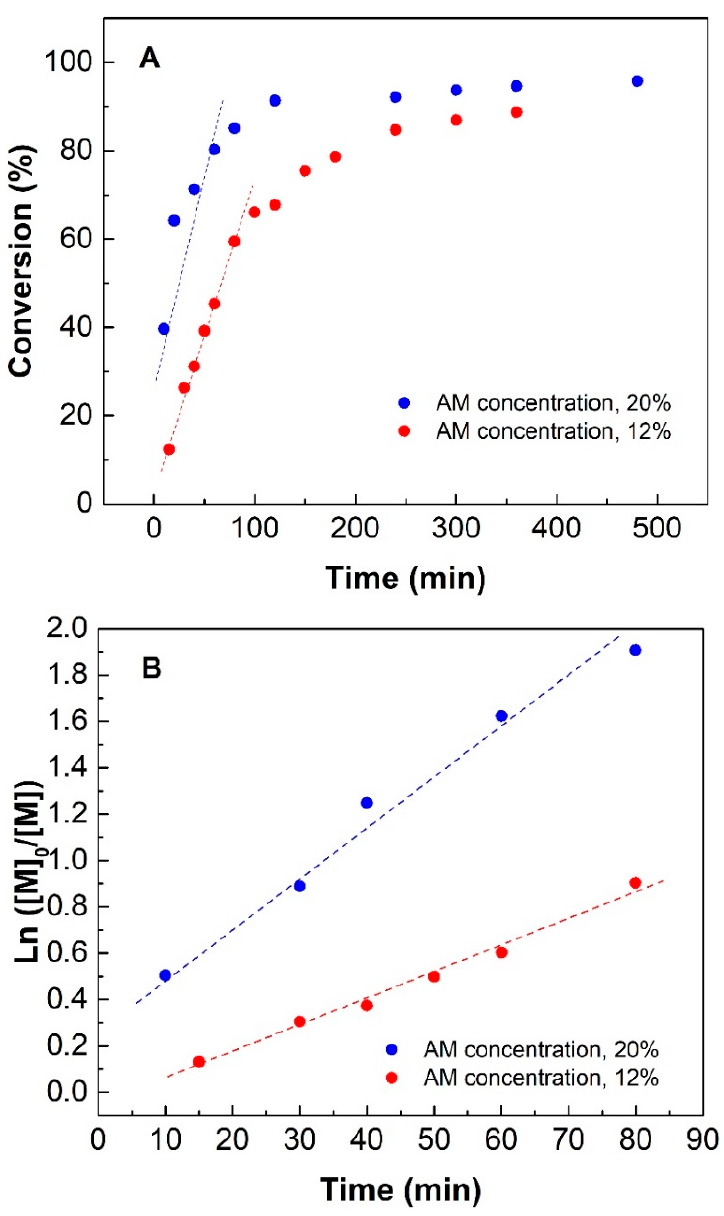
Figure 5. The kinetics plot of RAFT of AM with different concentrations (12% and 20%), including plot of conversion vs. time ( A ) and plot of ln([M] 0 /[M]) vs. time ( B ). Polymerization conditions: [M] 0 /[CTA] 0 /[AIBN] 0 , 200/1/0.1; temperature, 70 °C.